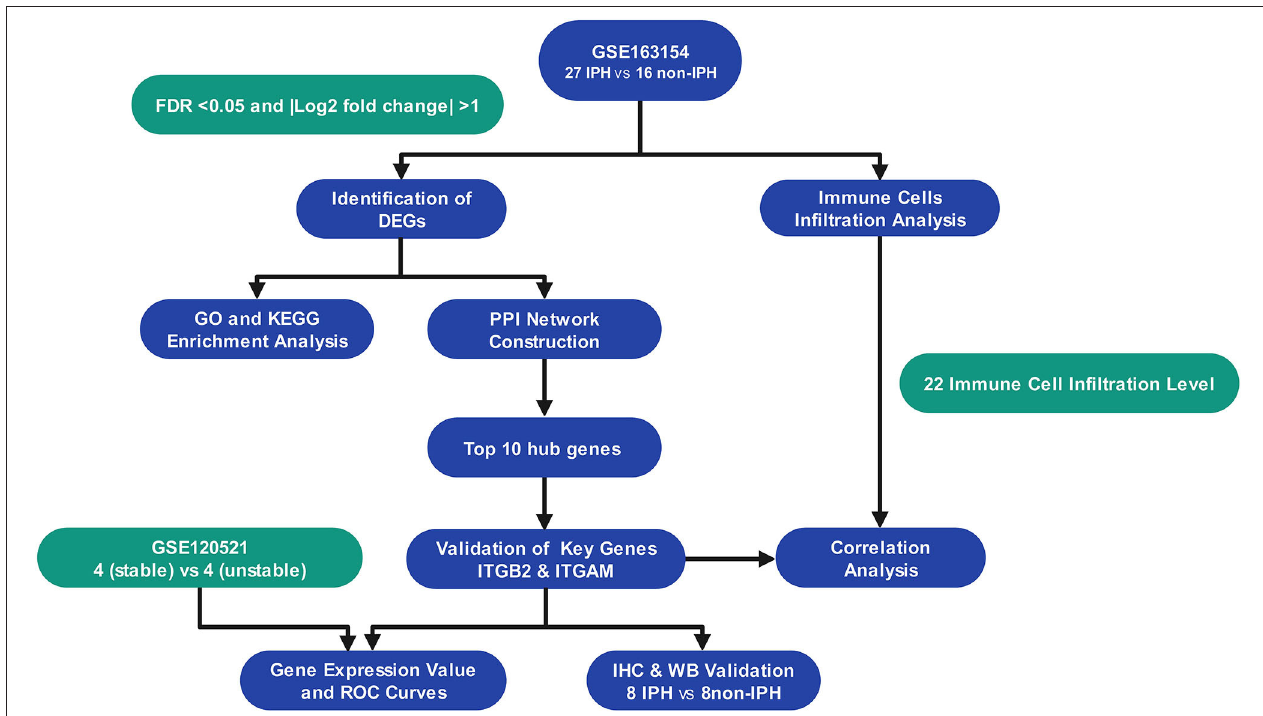
FIGURE 1 | The flowchart of the study.